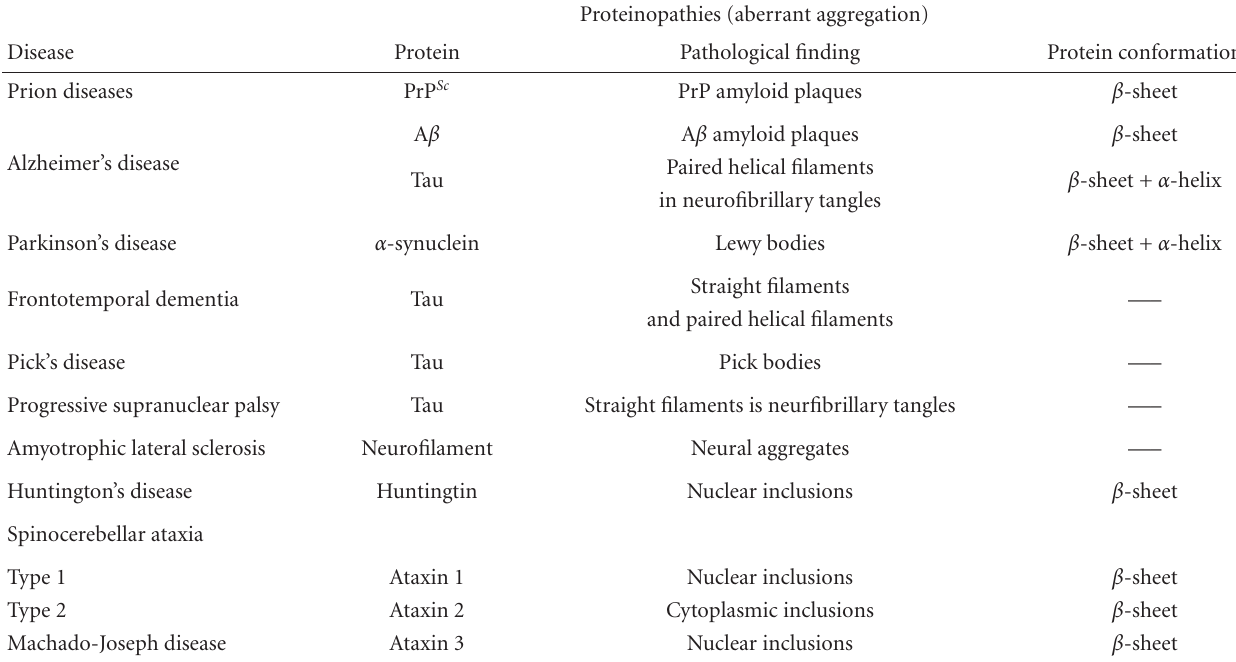
Table 1: Examples of neurological diseases where aberrant protein aggregates are found, and the suggested conformations in the aberrant aggregates are